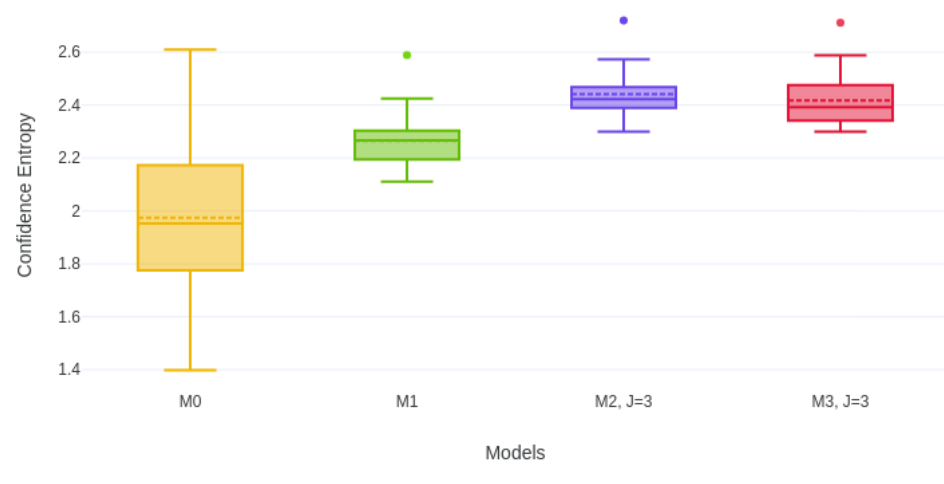
Figure 5. Entropy distribution across